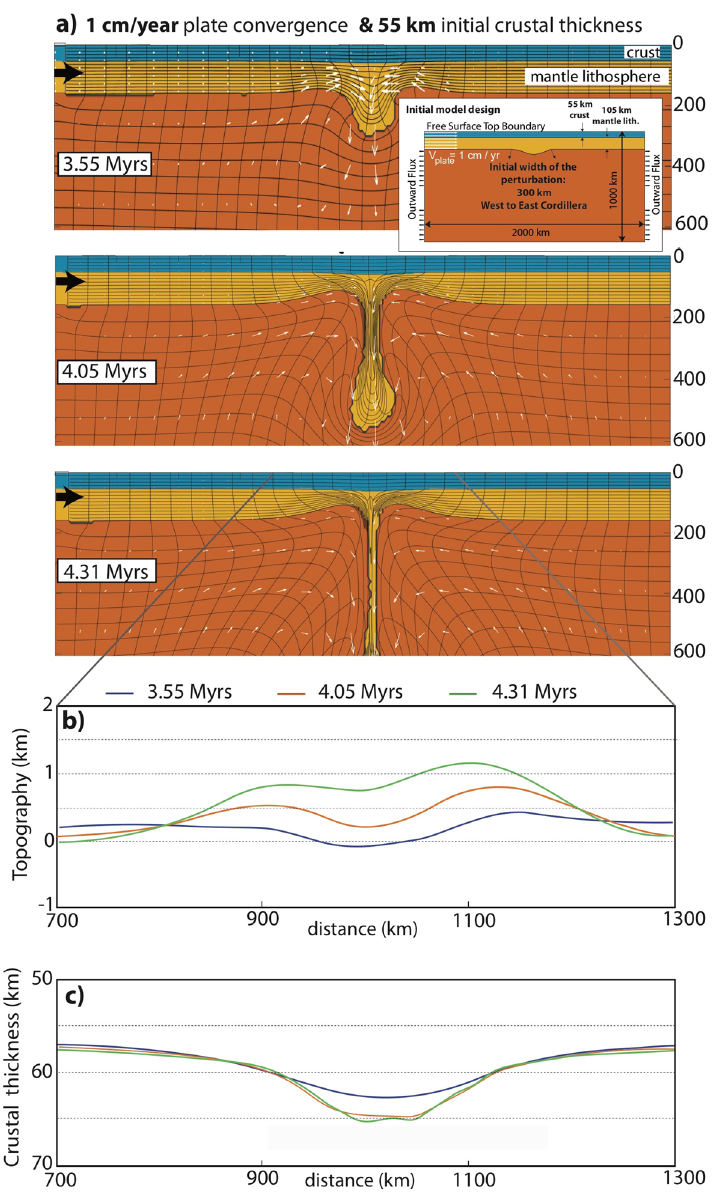
Figure 2. ( a ) Evolution of lithospheric (viscous drip type) removal (reference/preferred) model for timeframes 3.55 Myrs, 4.05 Myrs and 4.31 Myrs (approximately) corresponding to 10 Ma for the Peruvian part of the Central Andean Plateau. ( b ) Topographic evolution, ( c ) Crustal thickness variations for each timeframes shown in a. Plate convergence velocity Vp = 1 cm/year is applied on the left boundary of the model domain. The velocity boundary conditions are described as a constant inflow from the top to 160 km depth at the left boundary (LAB) with constant outflow imposed from beneath the lithosphere down to 1000 km depth through both sides. The magnitude of the outflow equals the volume of inflow to conserve the mass in the model domain. The lithosphere on the right margin is held fixed (pinned) for all model